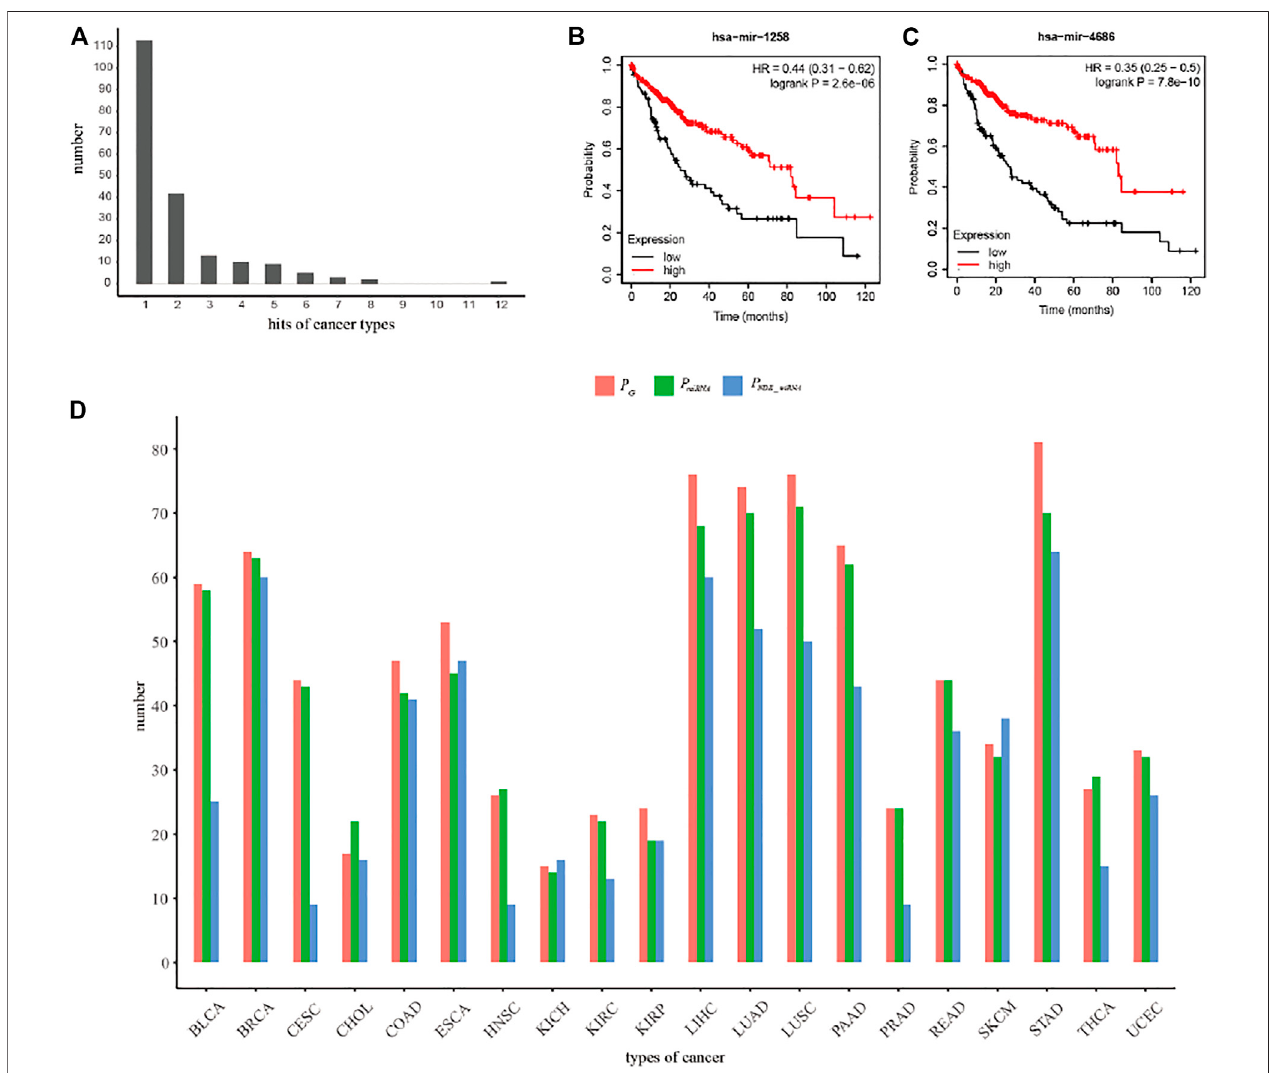
FIGURE 8 | The performance comparison of the MIMRDA method over other methods. (A) The number distribution of top-20 ranked cancer-related miRNAs. (B) ThesurvivalanalysisofmiR-1258inLIHC. (C) ThesurvivalanalysisofmiR-4686inLIHC. (D) TheperformancecomparisonamongtheMIMRDAmethod( P G ),theLimma package ( P miRNA ) and the SPIA package ( P NDE_miRNA ) based on the top-100 ranked miRNAs identi fi ed from the TCGA datasets of 20 types of cancer.